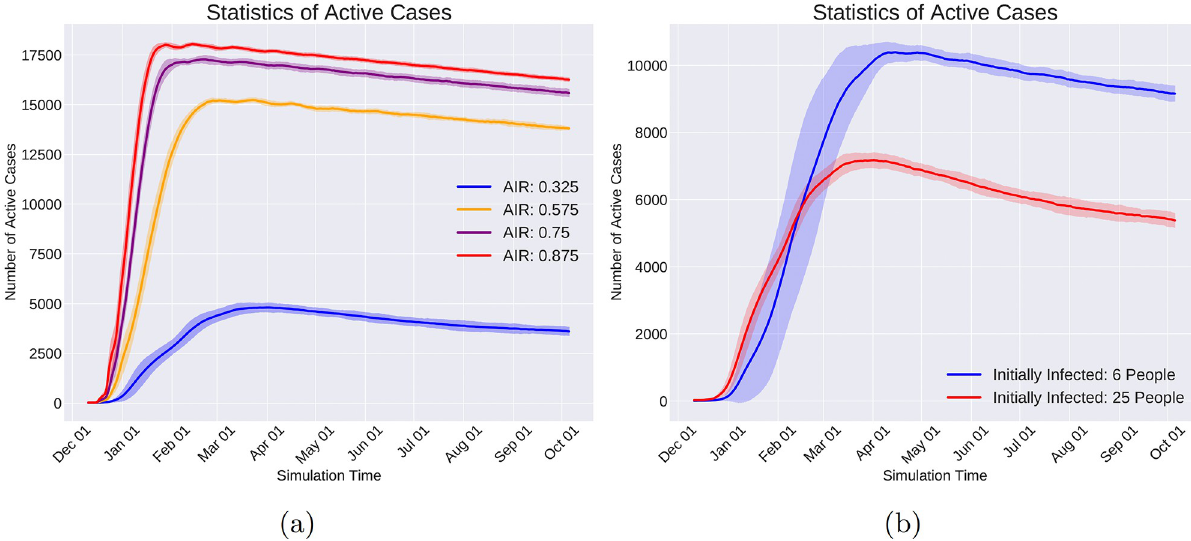
Fig 11. a) The number of currently infected individuals is plotted versus time for different values of the infection rates. The infection rates are sampled from uniform distributions with different mean values. It is observed that a larger infection rate increases the slope of the curve which means a faster spread of the disease early after the advent of the outbreak. As a result, it takes less time for the number of active cases to reach its peak. Notice that AIR stands for the Average Infection Rate, which is the mean of the distribution from which the infection rate is sampled. b) The spread of the infection is shown versus time for different numbers of initial spreaders where the smaller set is chosen from communities such as large workspaces and schools that are suitable places for infecting many people. The confidence intervals are expectedly wider for a smaller initially infected set because it results in some communities without an initial spreader and consequently a less homogeneous spread of the disease. The observation that the peak of the graph with a smaller initial set is higher than the one with a larger initial set emphasizes the hypothesis that some roles and places need special treatment early in an epidemic even though only a few of their individuals can be initially